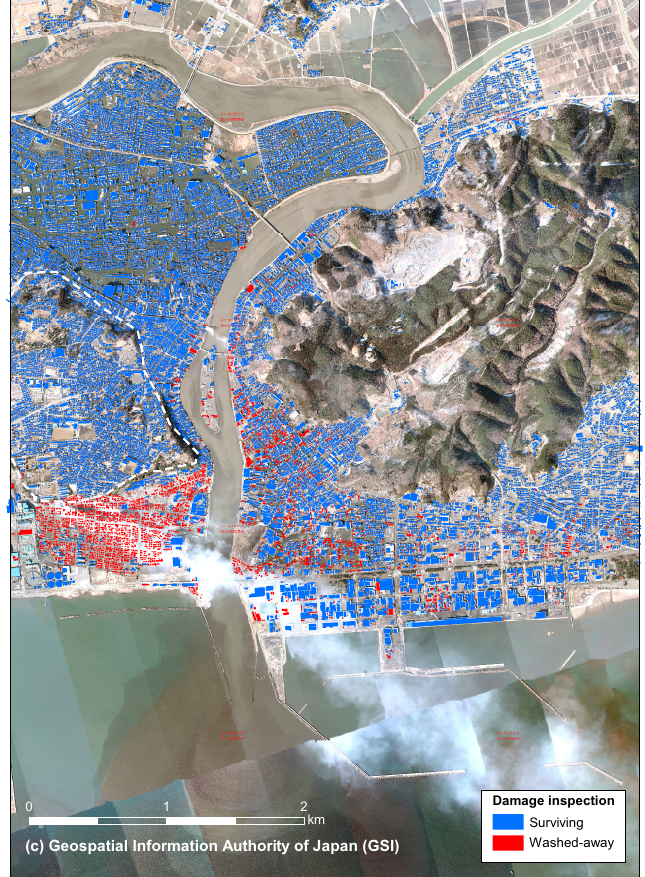
Figure 6. Example of mapping structural damage in Ishinomaki city by visual inspection of pre- and post-event aerial photos [23]. The aerial photo archives were provided by Geospatial Information Authority of Japan (GSI). With the ZENRIN building data (building footprint), the inspection was conducted to clarify if buildings were washed-away or surviving, by comparing pre- and post-tsunami aerial photos and looking at existence of each building’s